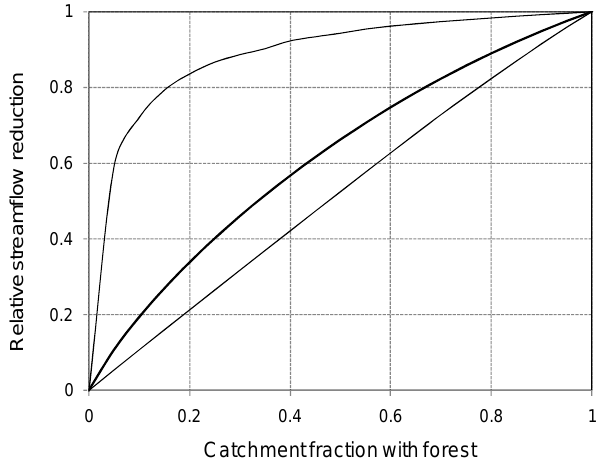
Fig. 5. The theoretical maximum influence of lateral water redistribution, from herbaceous to forest areas, on mean streamflow ( Q ) as predicted by the AWRA-L model for 278 Australian catchments. The middle bold and two outer lines represent the catchments with the median and most extreme responses, respectively. Q reduction is shown relative to the difference between the 0 and 100% forest cover cases (in the absence of redistribution a linearly proportional influence would be predicted).